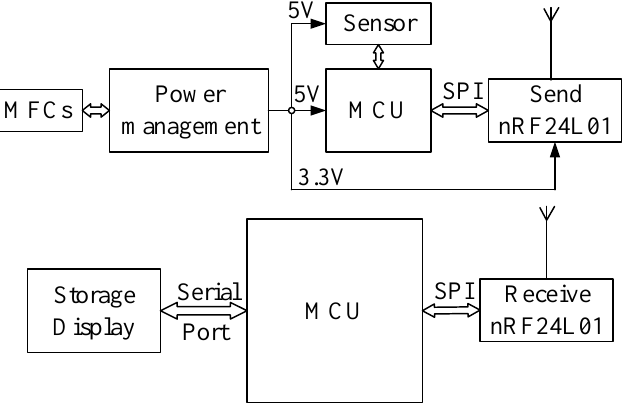
Figure 4. Schematic of the sensor and telemetry system driven by the